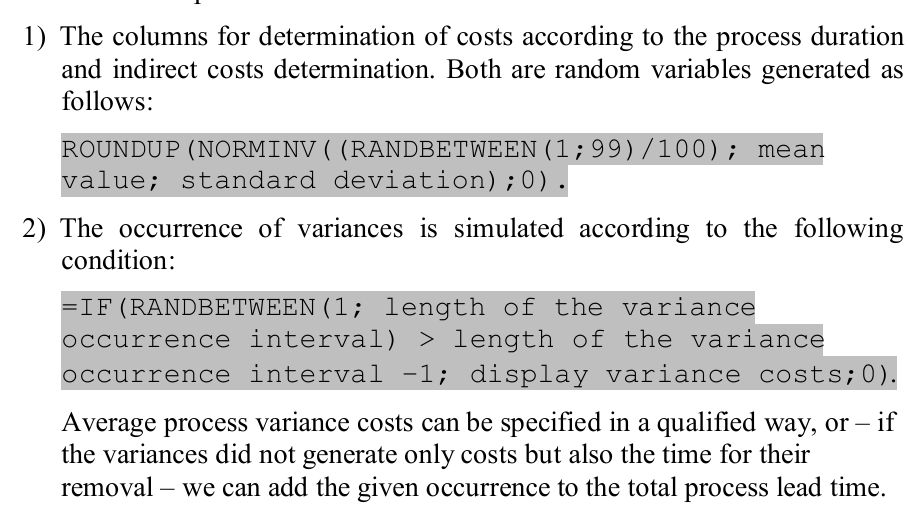
Frequency of failure occurrence